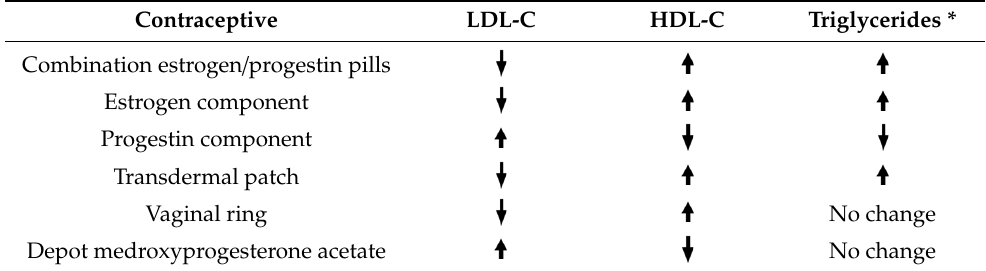
Table 4. E ff ects of hormonal contraceptives on lipid levels. Table 4. Effects of hormonal contraceptives on lipid levels. Table 4. Effects of hormonal contraceptives on lipid levels. Table 4. Effects of hormonal contraceptives on lipid levels. Table 4. Effects of hormonal contraceptives on lipid levels. Table 4. Effects of hormonal contraceptives on lipid levels. Table 4. Effects of hormonal contraceptives on lipid levels. Table 4. Effects of hormonal contraceptives on lipid levels. Table 4. Effects of hormonal contraceptives on lipid levels. Table 4. Effects of hormonal contraceptives on lipid levels. Table 4. Effects of hormonal contraceptives on lipid levels. Table 4. Effects of hormonal contraceptives on lipid levels. Table 4. Effects of hormonal contraceptives on lipid levels. Table 4. Effects of hormonal contraceptives on lipid levels. Table 4. Effects of hormonal contraceptives on lipid levels. Table 4. Effects of hormonal contraceptives on lipid levels. Table 4. Effects of hormonal contraceptives on lipid